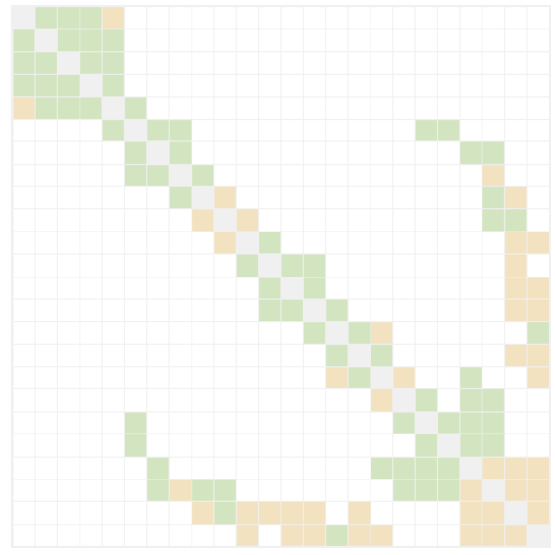
Figure 9. Case Study 1: matrix showing the results of scan pairwise registration using a surface-based approach.